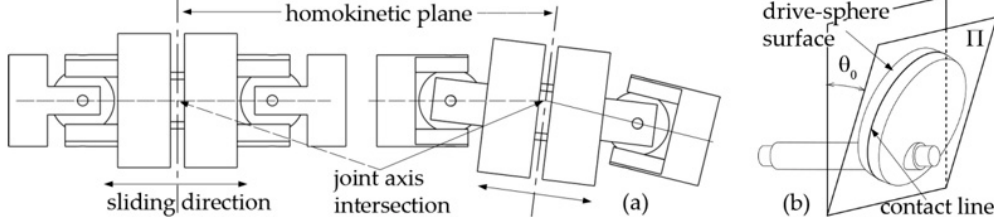
Figure 10. CAD model of the transmission system designed to drive the robotic tail at t = 0.